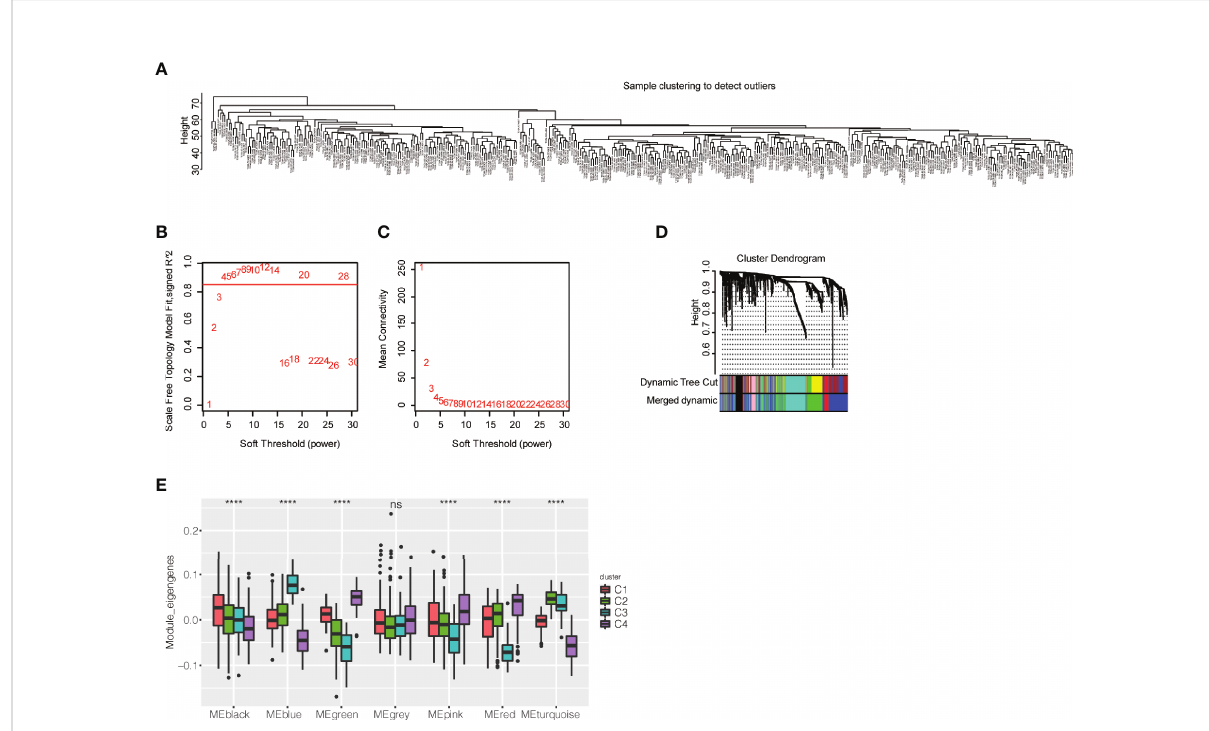
FIGURE 7 Exploration of coexpression modules of immune-related genes. (A) Clustering of patients with bladder urothelial carcinoma based on the expression pro fi le of immune-related genes. (B) Scale-free topology model for the identi fi cation of multiple soft thresholds. (C) Mean connectivity for multiple soft thresholds. (D) Cluster dendrogram and module colors. (E) Module eigengenes of seven modules in the immune subtypes of bladder urothelial carcinoma ns, p ≥ 0.05; and ****p <